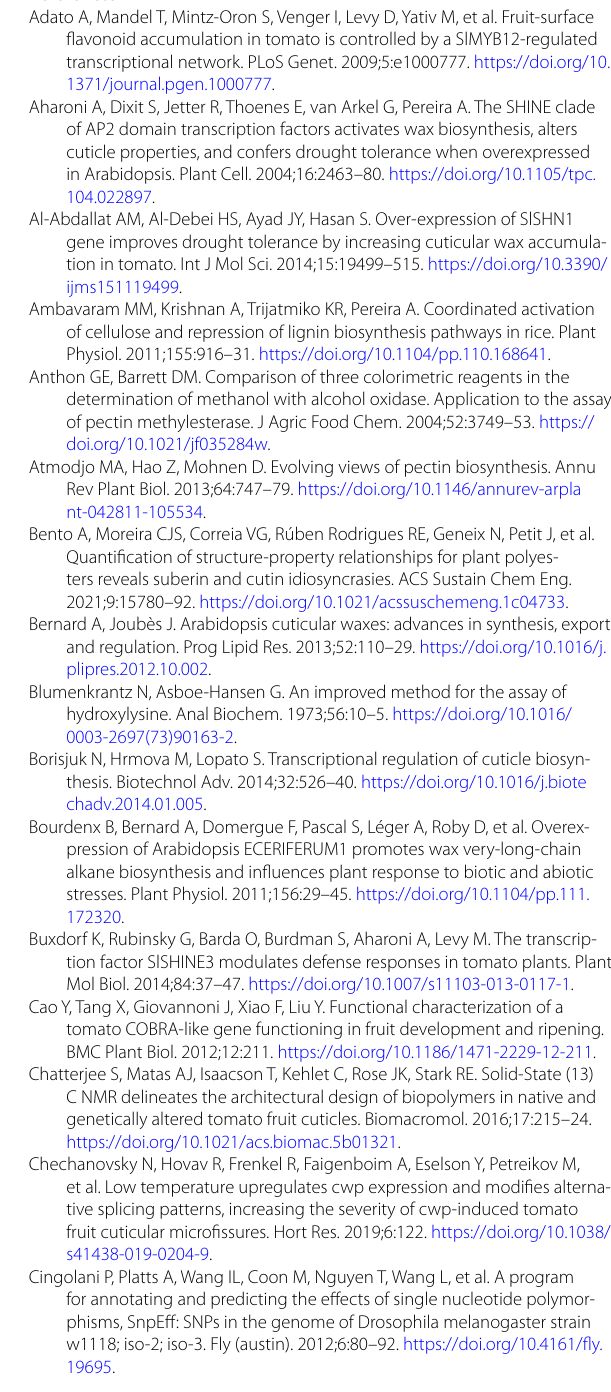
tal Figure S2. Transcripts variants of SlSHN2. Supplemental Figure S3. Developmental, cuticular and epidermal phenotypes of WT-like plants. Supplemental Figure S4. Distribution of down- and up-regulated genes in 20 DPA fruit exocarp of WT ‐ like and